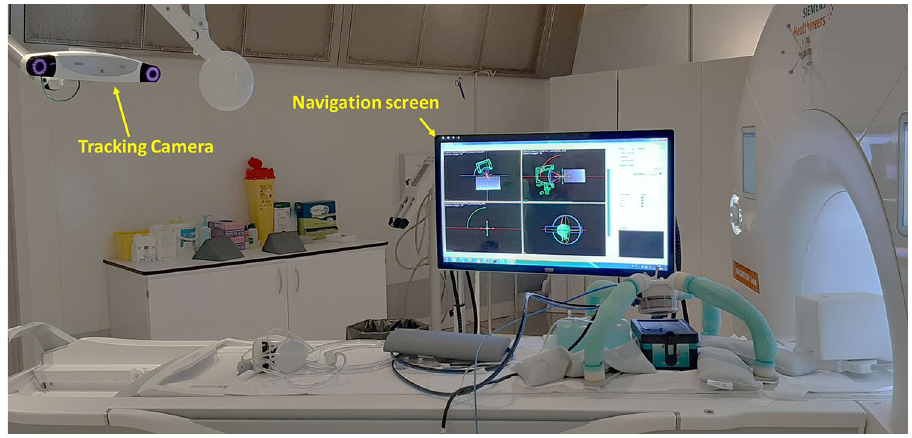
Figure 4. Photograph of the MR room